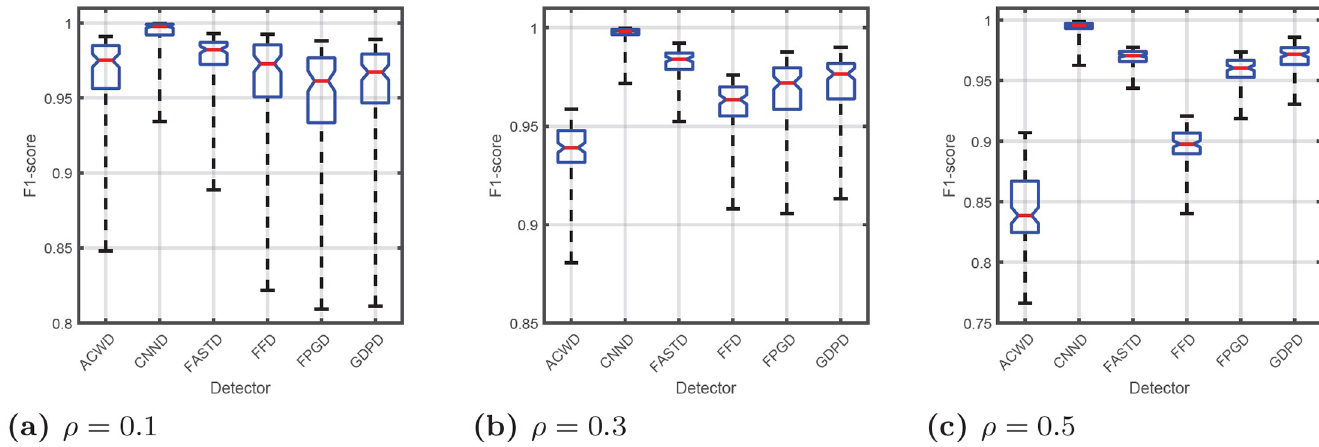
Fig 2. Impulse detection performance. Evaluated with F1-score